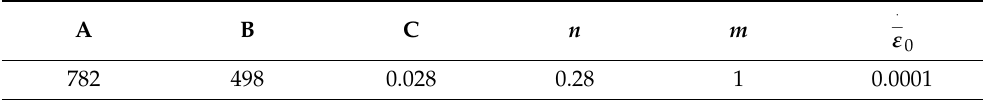
Table 1. Johnson–Cook constitutive model parameters of Ti-6Al-4V [23].